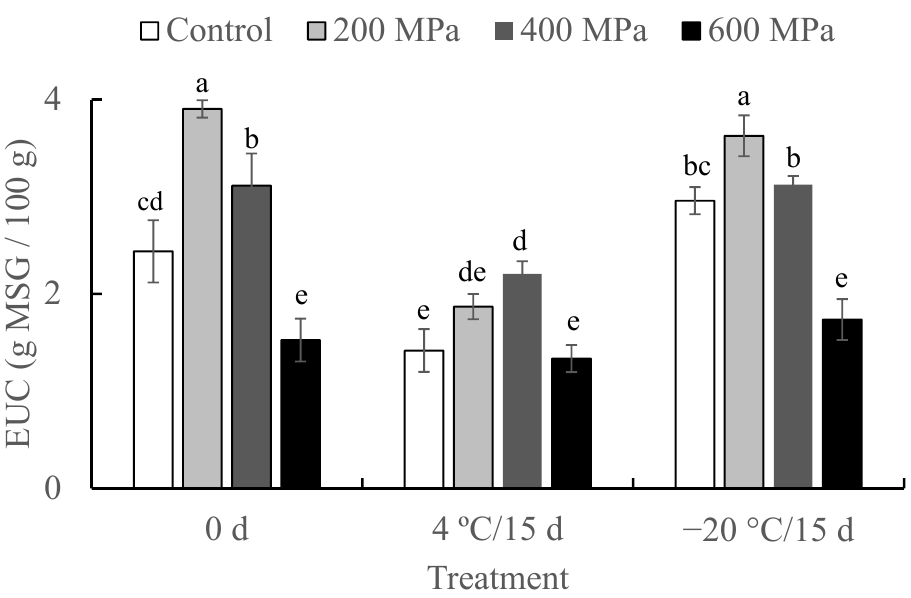
Figure 1. The equivalent umami concentration (EUC, g MSG/100 g wet weight) of red claw crayfish with different treatments. Bars with different letters denote significantly different ( p < 0.05).